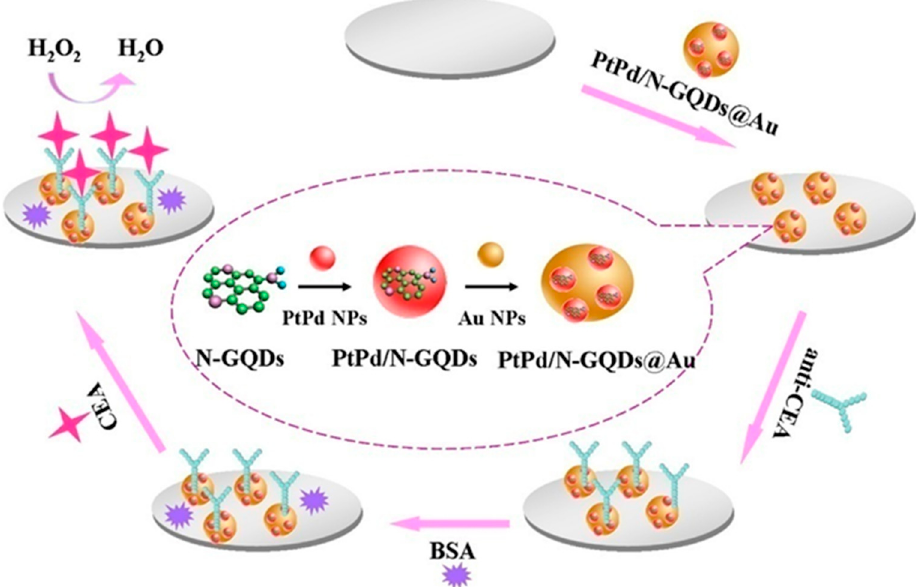
Figure 5. Schematic representation of the label ‐ free electrochemical immunosensor and the prepa ‐ ration procedure of PtPd/N ‐ GQDs@Au for the detection of carcinoembryonic antigen (CEA). Adapted with the permission of Ref.